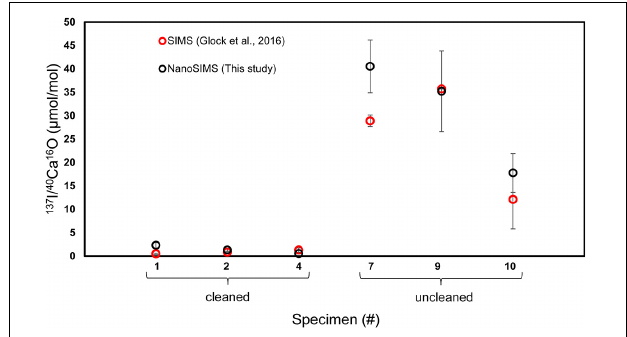
FIGURE 8 | A comparison of quantitative I/Ca ratios ( µ mol/mol) measured on the same six specimens of U. striata from the Peruvian OMZ with NanoSIMS (this study) and SIMS (Glock et al., 2016). Specimens 1, 2, and 4 were treated with an oxidative cleaning procedure before embedding for the preparation of the cross-sections, while specimens 7, 9, and 10 are